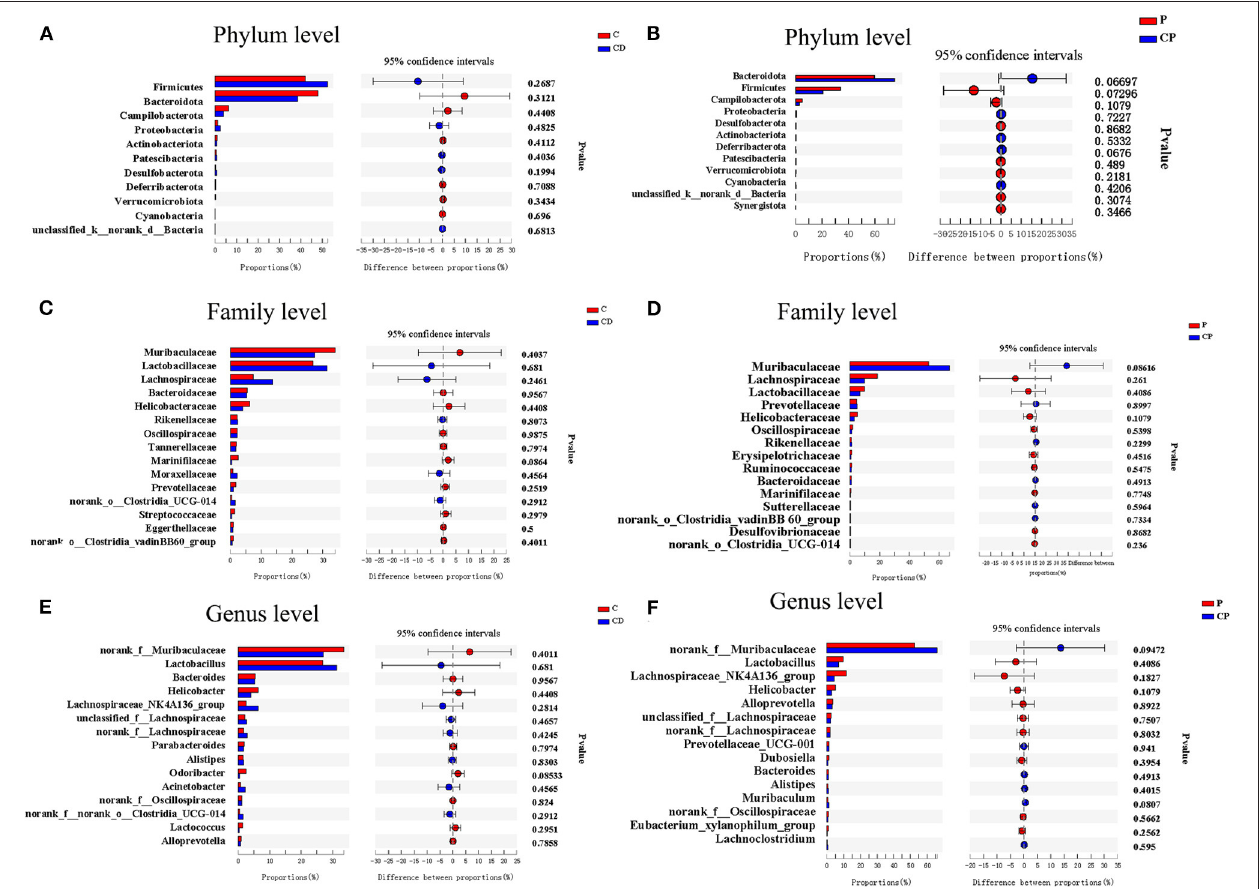
FIGURE 8 | Bar plots of Welch’s t -test at the phylum, family, and genus levels ( n = 9–10). (A) C group and CD group at the phylum level. (B) P group and CP group at the phylum level. (C) C group and CD group at the family level. (D) P group and CP group at the family level. (E) C group and CD group at the genus level. (F) P group and CP group at the genus level. * P <